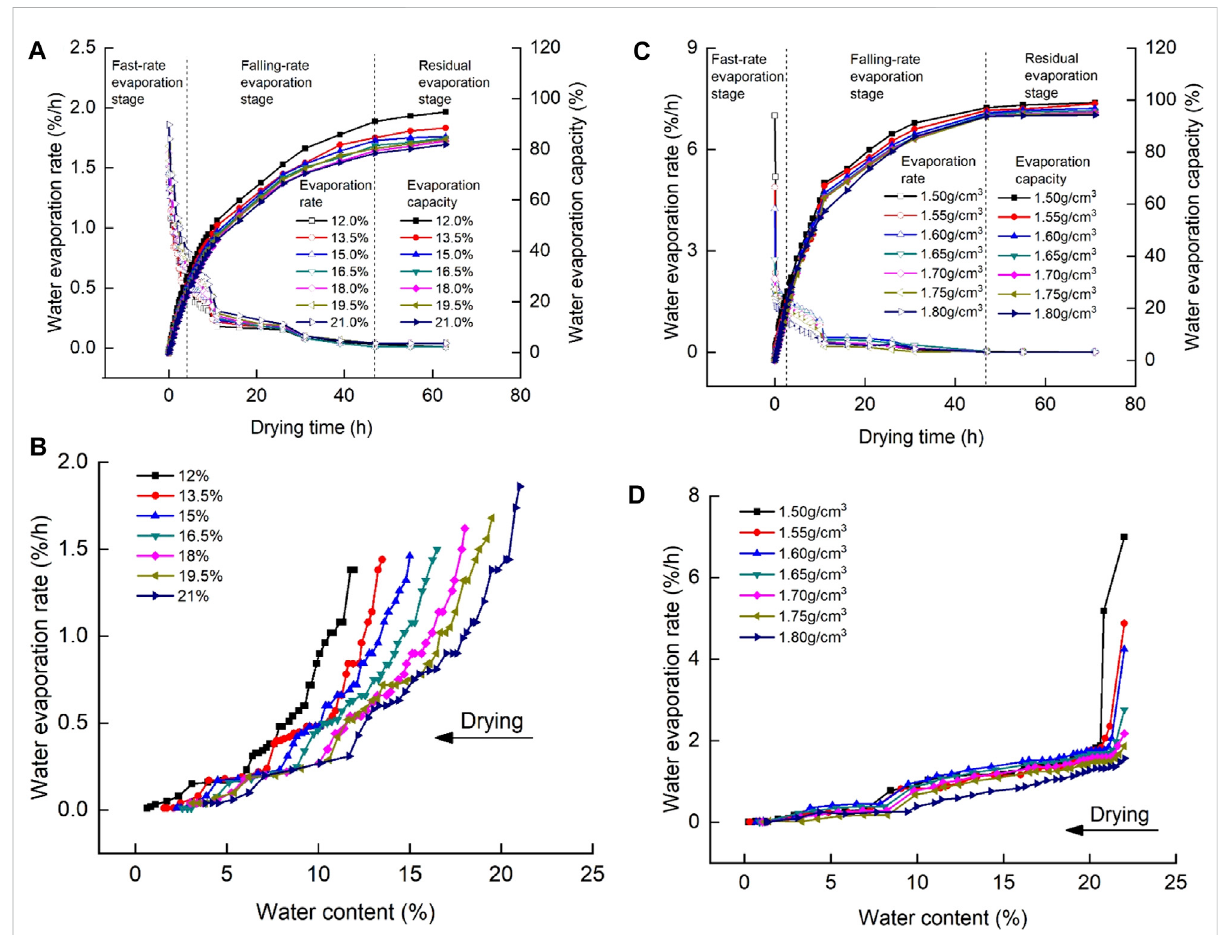
FIGURE 4 Changes of the water evaporation capacity and water evaporation rate of specimens during drying. (A) Water evaporation of specimens of different initial water content with time, (B) Water evaporation rate of specimens with different initial water content, (C) Water evaporation of specimens of different initial density with time, and (D) Water evaporation rate of specimens with different initial